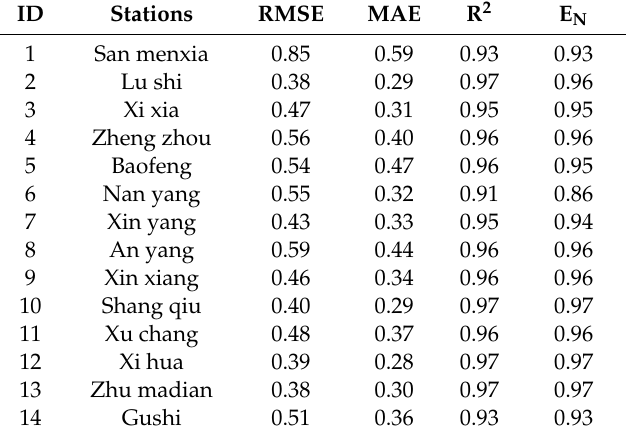
Table 5. The multiple hidden layer back propagation (MBP) model performances tested at di ff erent stations with full meteorological inputs